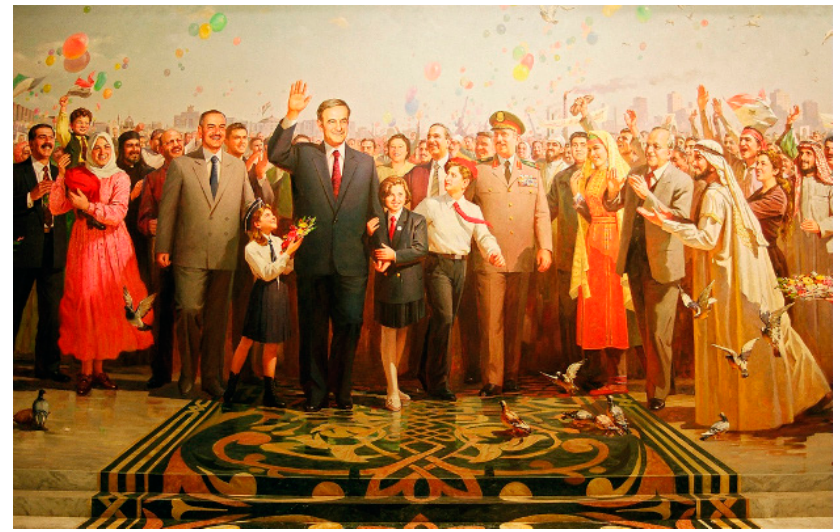
Figure 3. Grand-scale mural staging Syria’s victory over Israel in the Yom Kippur War in lieu of defeat (n.d.). Damascus, Syria: October War Panorama Museum. Source: Stone Fish (2013), open access.